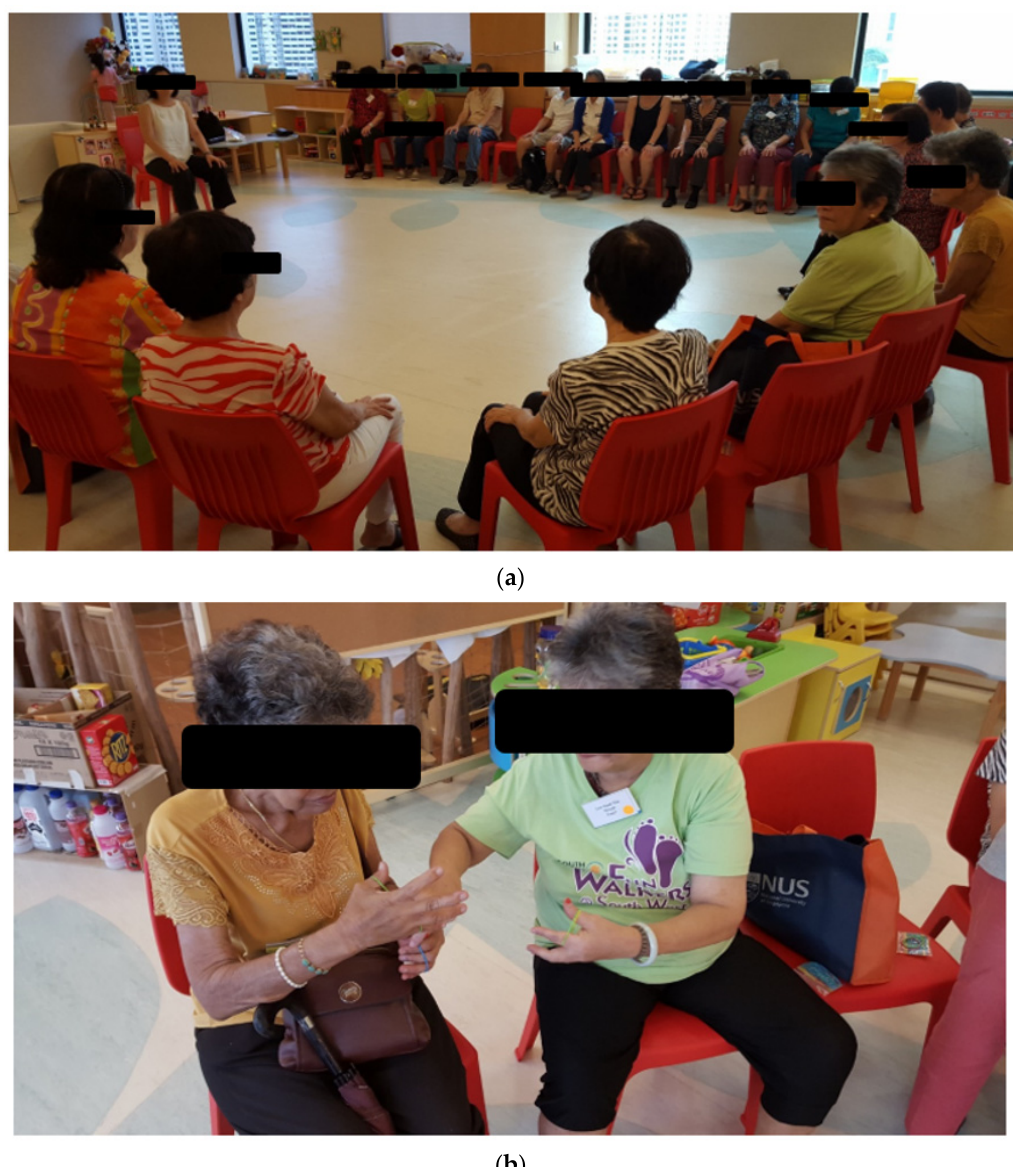
Figure 3. ( a , b ). Examples of MAP intervention sessions (top: mindful breathing, bottom: visual-motor coordination task).